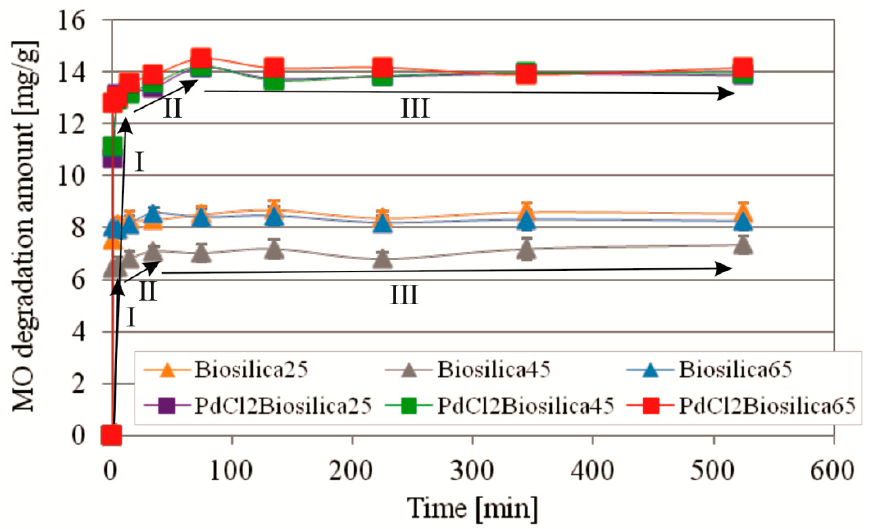
Figure 5. Kinetic curves of MO photocatalytic degradation under UV irradiation using PdCl2 biosilica and biosilica photocatalyst. Experimental conditions: m (Biosilica)—10 mg; T = 25 °C; C 0 (MO)—9.98 mg/L; V (MO solution)—15 mL; pH—7.0.